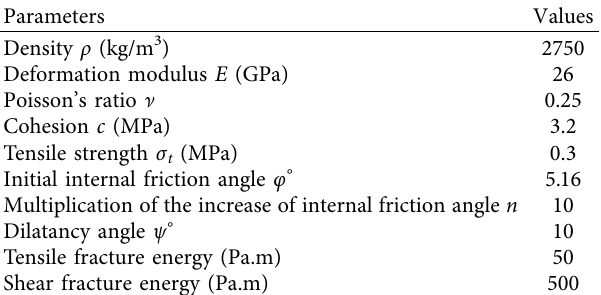
Table 5: Mechanical parameters for